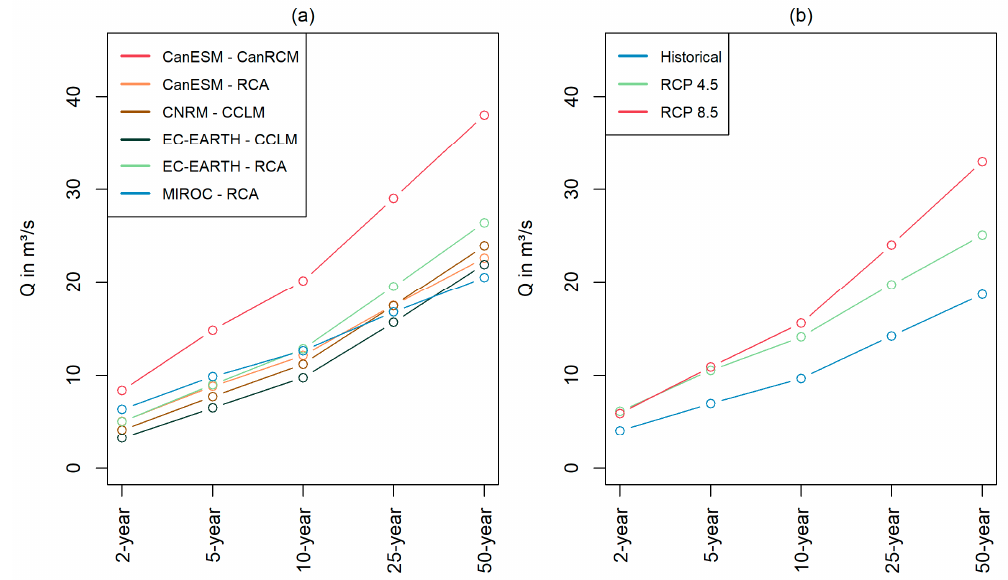
Figure 11. Impact of climate change on the return periods of the highest daily discharge over the year. ( a ) is the arithmetic mean for each model across the two RCP scenarios, and ( b ) is the arithmetic mean for each climate scenario across all six models.